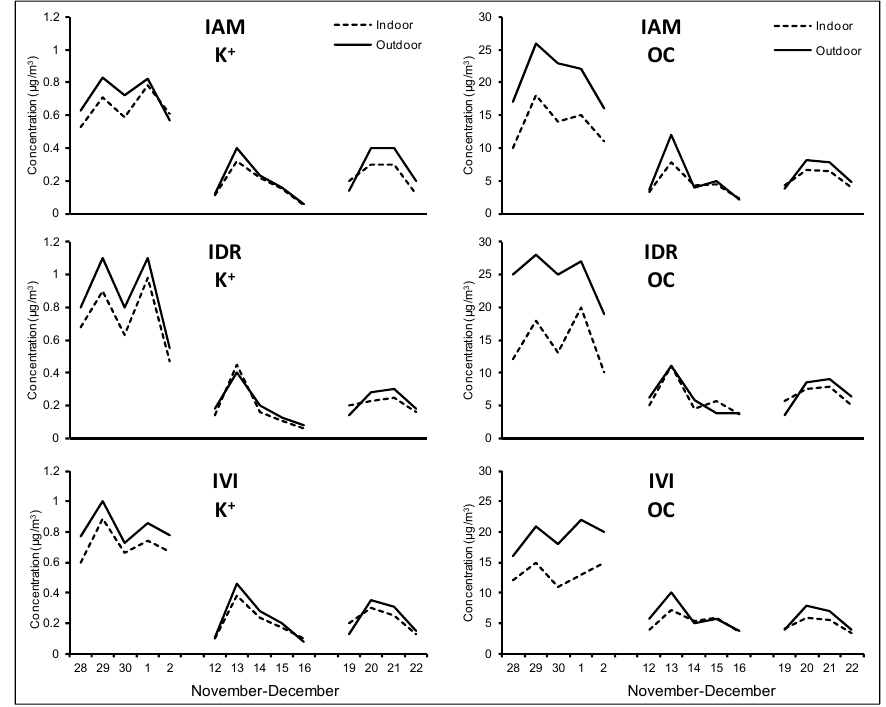
Figure A5. K + and OC daily concentrations measured outdoor (solid lines) and indoor (dotted lines) at the three schools during the winter